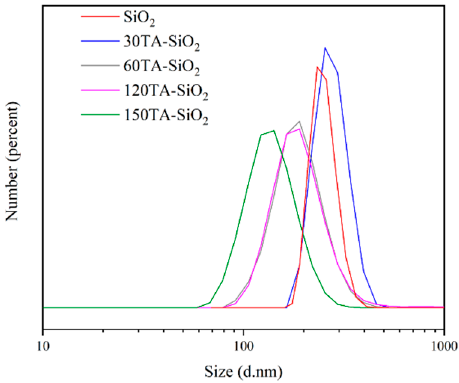
Figure 2. DLS profile of TA-SiO 2 NPs in deionized water at room